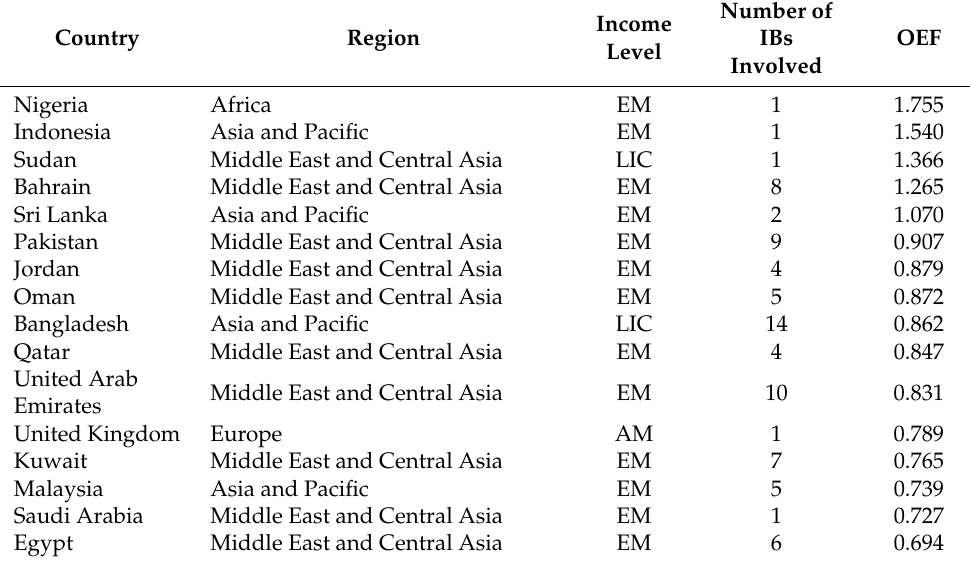
Table 4. Country-wise performance of the IBs.